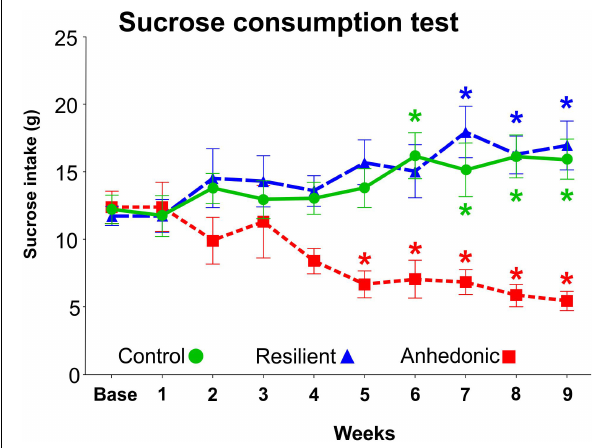
FIGURE 3 | Results of the sucrose consumption test. The sucrose intake of the rats was determined every week in order to behaviorally phenotype the animals and to evaluate their response to the chronic mild stress exposure. The original CMS study involved 335 rats. 260 rats were subjected to the CMS protocol, whereas the remaining 75 rats were kept undisturbed in separate rooms and used as controls. About 40% of the stressed rats ( n = 98) were vulnerable to stress and significantly reduced their sucrose intake by > 30%. These animals were then labeled as “anhedonic” rats. Out of these 98 anhedonic rats 4 animals were selected for the present quantitative electron microscopic analysis based on their marked reduction in sucrose intake. About 20% of the stressed rats ( n = 46) were unaffected by the stress exposure and even increased their sucrose intake, similarly to the control animals. These stress resistant rats were labeled as “stress-resilient”. The remaining stressed animals ( n = 116) with intermediate sucrose consumption phenotype were excluded from the experiment. Baseline sucrose consumption was defined as the mean sucrose consumption during three sucrose tests conducted before the stress protocol started. Statistics: one-way ANOVA, followed by Dunnets’s multiple comparison tests where results are compared of the baseline sucrose consumption of the corresponding group. * P < 0.05 versus baseline value of the same group.